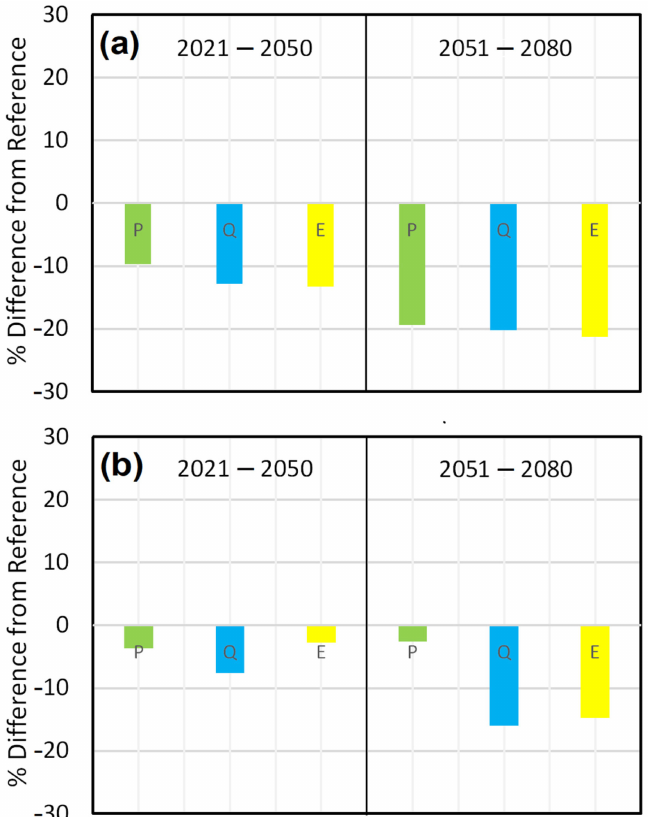
Figure 15. Variations in the projections of precipitation (P) and flow rate (Q) in Altamira and of energy generation (E) at Belo Monte, for the 2021–2050 (left) and 2051–2080 (right) periods, based on the RCP 4.5 ( a ) and the RCP 8.5 ( b )